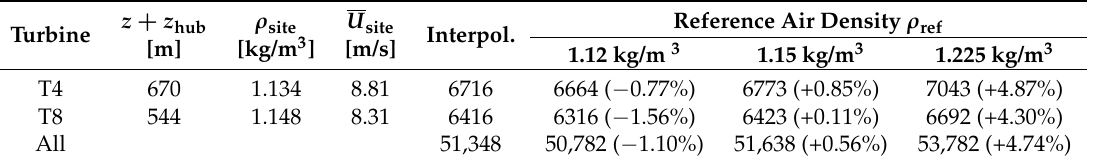
Table 2. Annual energy production [GWh] calculated by Wind Atlas Analysis and Application Program (WAsP) 12 CFSR for the turbines with the lowest and highest air density and for the entire Parque Fictio test wind farm using power curves adapted to individual turbine sites or selected reference air